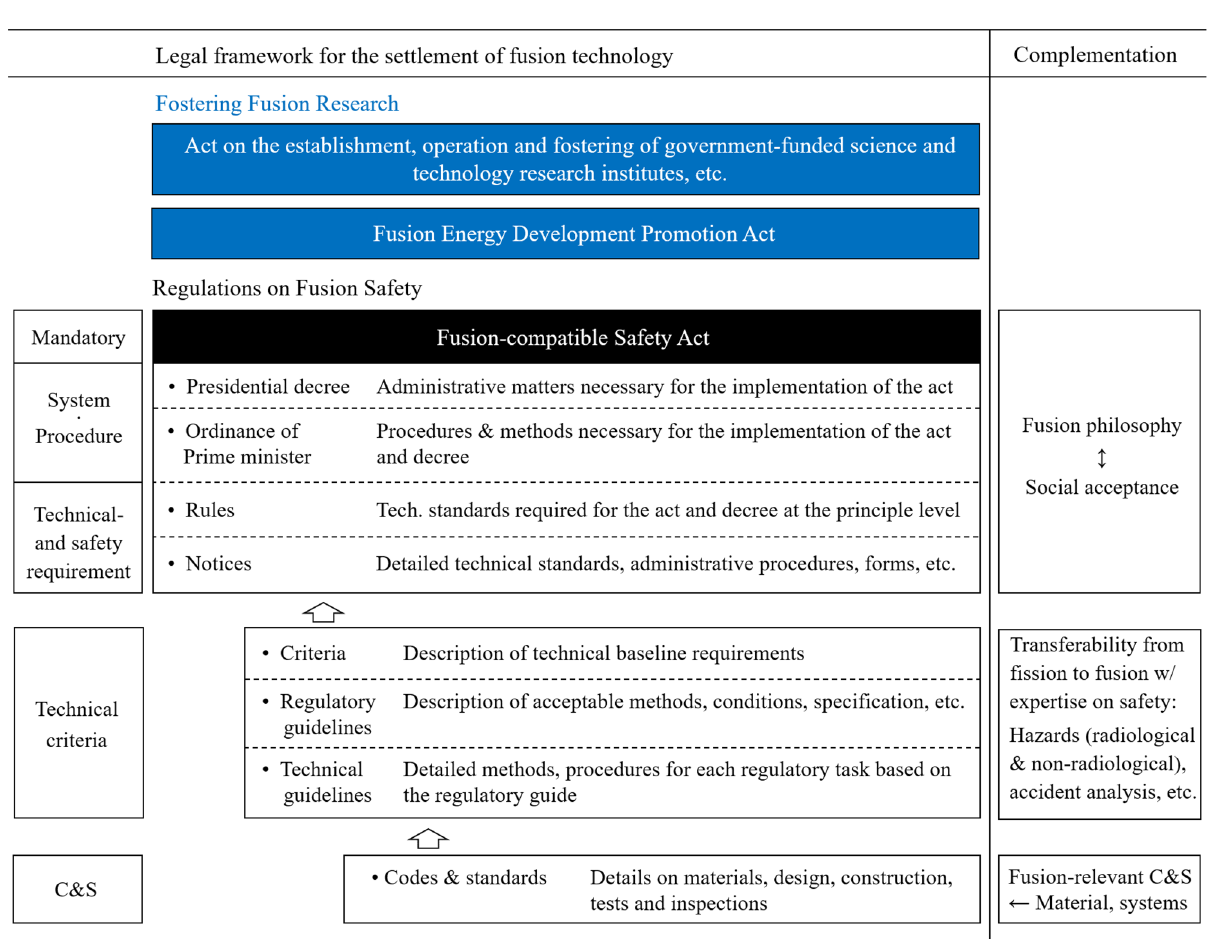
Figure 7. Outline of the proposed legislative environment in Korea to promote fusion research toward the DEMO stage and to impose legal measures to regulate its design, installation, construction, operation, and